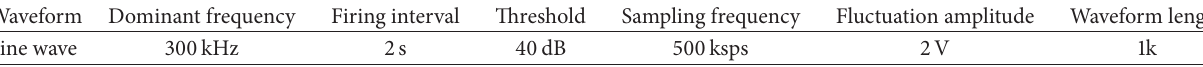
Table 2: The detailed information of the generated ultrasonic